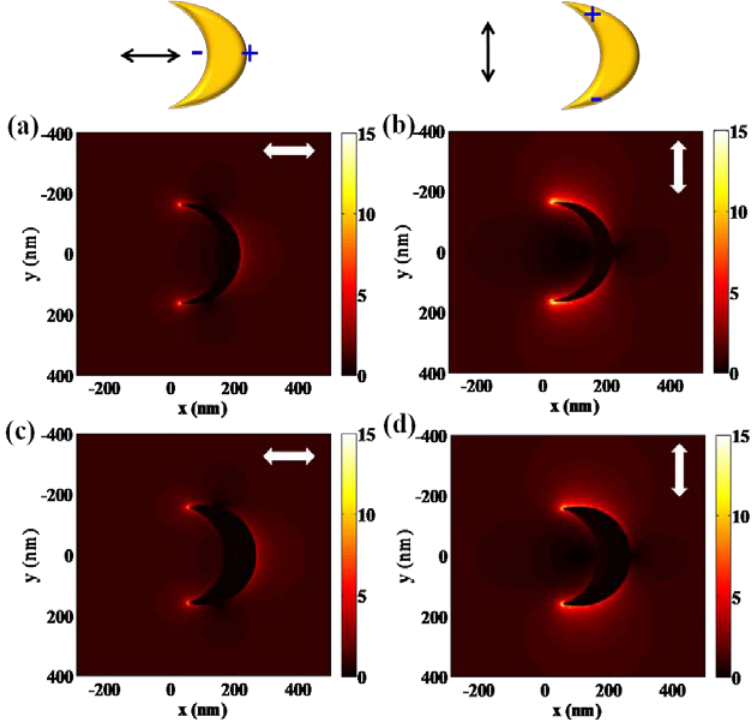
Figure 5. Intensity distributions (arbitrary unit) of nanocrescent with respect to the width of nanocrescent and incident polarization state of light. (a) 50 nm wide and horizontally polarized light; (b) 50 nm wide and vertically polarized light; (c) 100 nm wide and horizontally polarized light; (d) 100 nm wide and vertically polarized light.